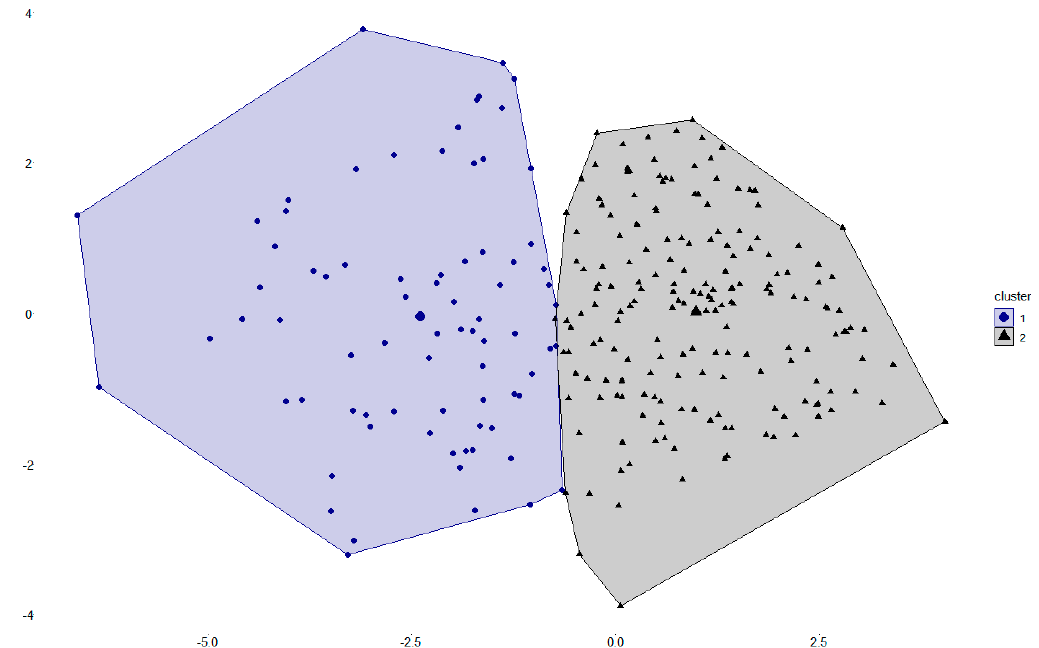
Figure 1. Partitioning clustering plot of the GDBI-E items. Cluster 1 represents participants who mainly follow a less healthy dietary behavior-related to the international nutrition recommendations. Cluster 2 represents participants who mainly follow a healthier dietary behavior-related to the international nutrition recommendations. The larger points indicate the respective cluster centers.